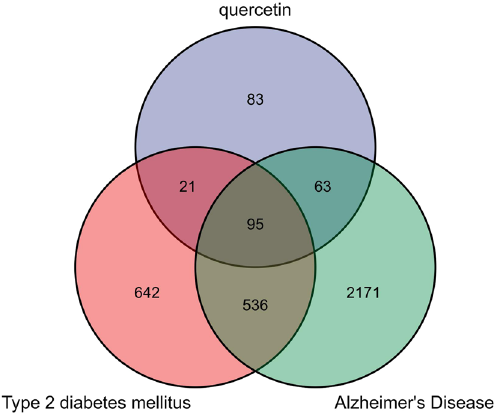
Figure 2. Venn diagram showing the overlap among quercetin targets (blue), T2DM-related gene products (red), and AD-related gene productions (green). A total of 95 gene products were identified as common.